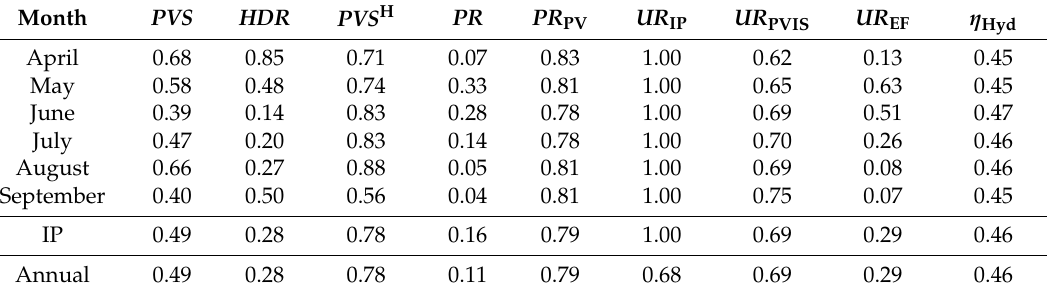
Table 7. Real performance indices in